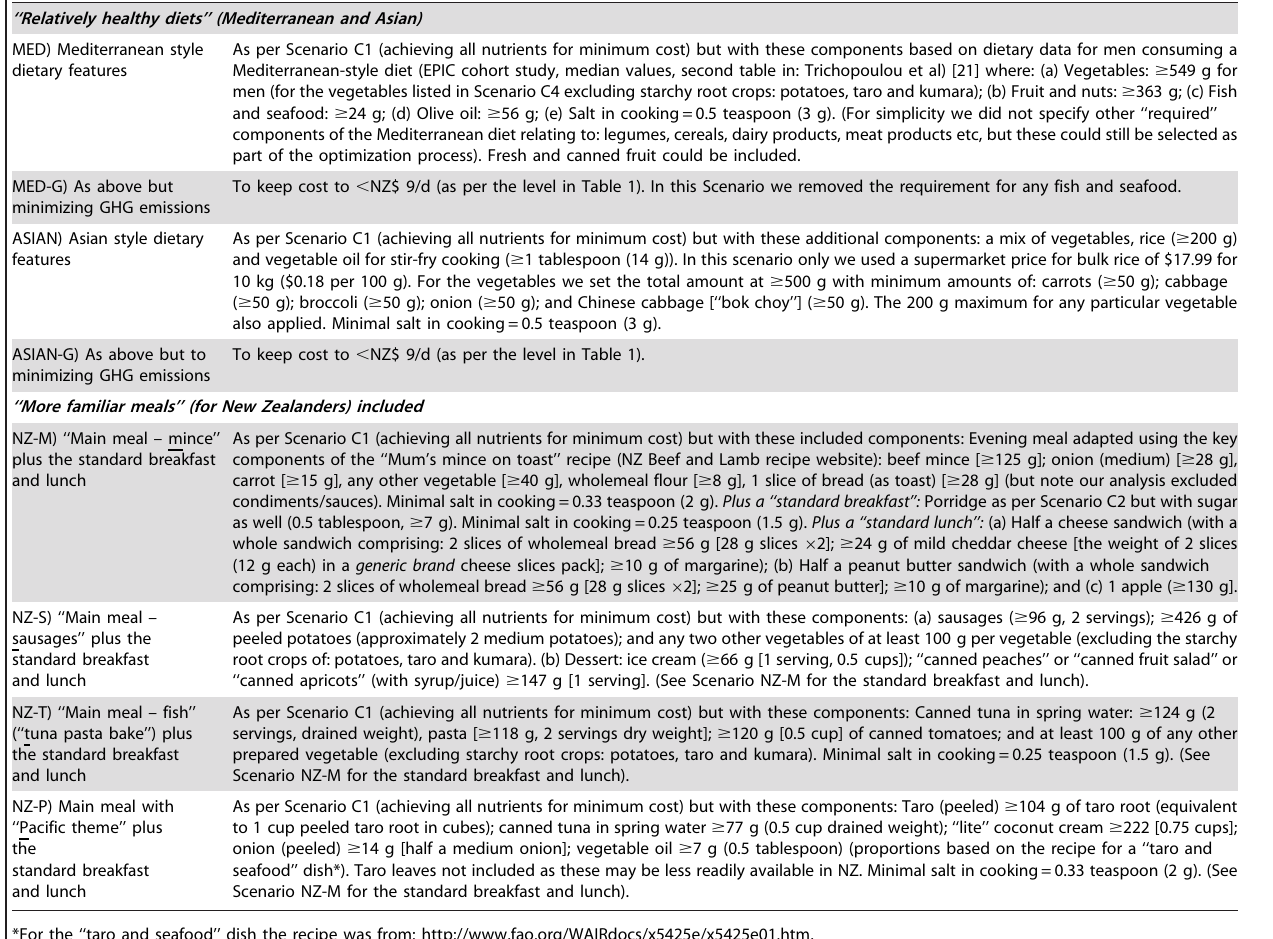
Table 2. Additional scenarios covering specific dietary patterns and aspects of the New Zealand